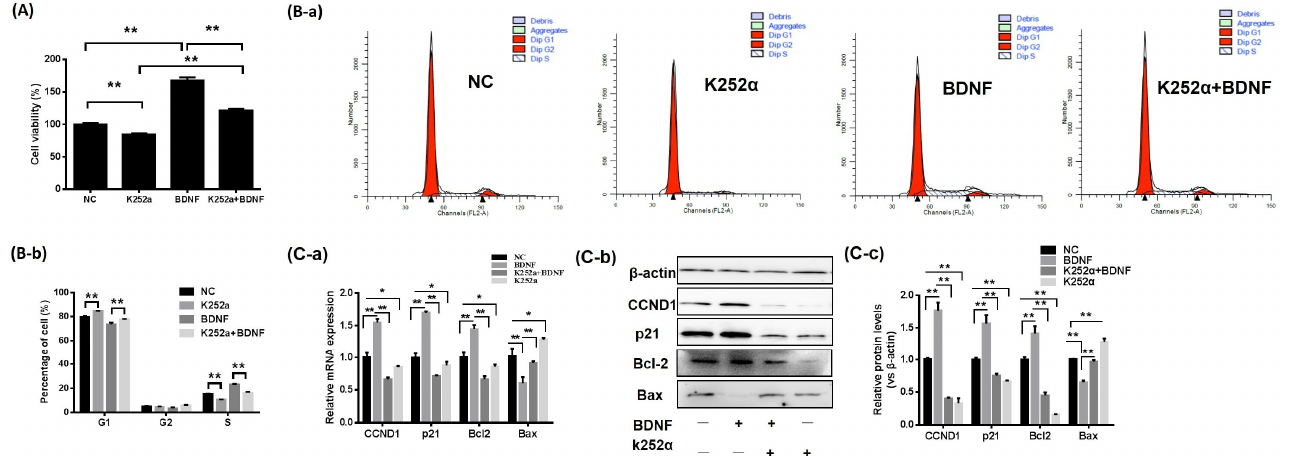
Figure 2. The BDNF/TrkB pathway affects the proliferation of porcine GCs. After 30 min of prein- cubation with K252a (100 ng/mL) porcine GCs are incubated with BDNF (100 ng/mL) for 24 h. ( A ) CCK-8 assay is then performed to assessed the viability of the GC. ( B-a , B-b ) FASC is employed to analyze the cell cycle in porcine GCs. ( C ) RT-qPCR and Western blotting are performed to determine the mRNA ( C-a ) and protein ( C-b , C-c ) expression levels of Bcl2, Bax, p21 and CCND1. Data are presented as mean ± SD, n = 3; * p < 0.05, ** p < 0.01.